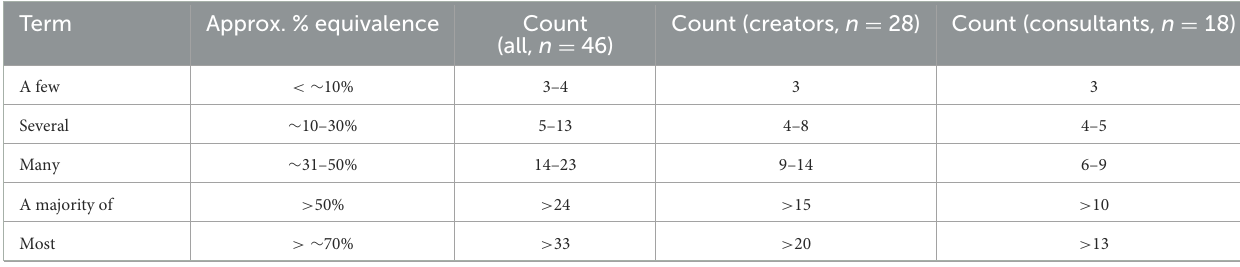
TABLE 1 Terms for qualitative abundance.